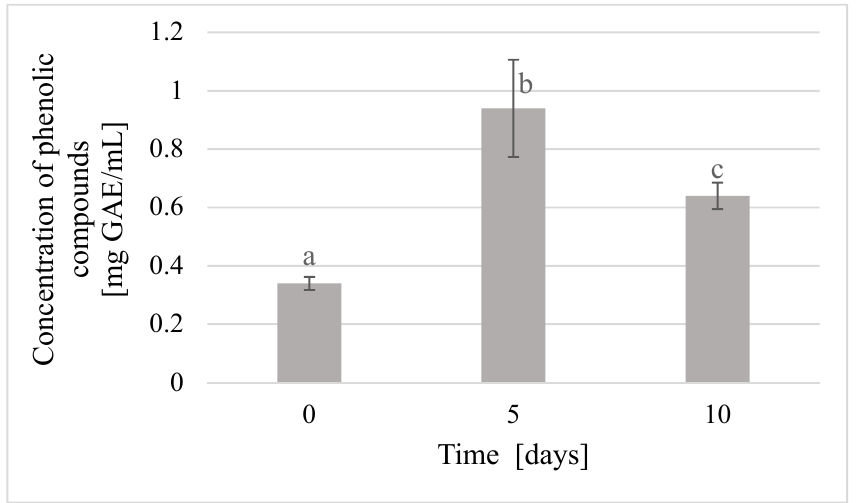
Figure 5. An effect of storage time on the content of phenolic compounds in beebread caviar; p a-b = Figure 5. An e ff ect of storage time on the content of phenolic compounds in beebread caviar; 0.00345; p b-c = 0.04104 . p a-b = 0.00345; p b-c =